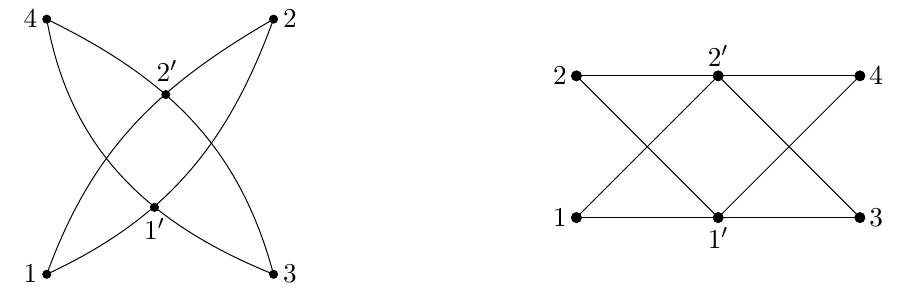
Figure 19. On the left, a diagram showing an event shape for L [ φ 2 ] L [ φ 2 ] , embedded inside the four-point correlator h φ 2 φ 2 φ 2 φ 2 i . We imagine φ 2 ( x 1 ) φ 2 ( x 2 ) creating the detector L [ φ 2 ] L [ φ 2 ] via the mechanism in figure 18. This detector is then measured in states created by φ 2 ( x 3 ) and φ 2 ( x 4 ) . On the right, we re-draw the same diagram in a simpler way that makes clear that it is the square of the kernel S , which is one of the terms inside SG tree in equation